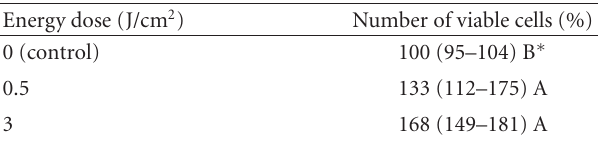
Table 2: Number of viable cells (%) detected by the trypan blue assay, according to the energy doses used in the low-level laser